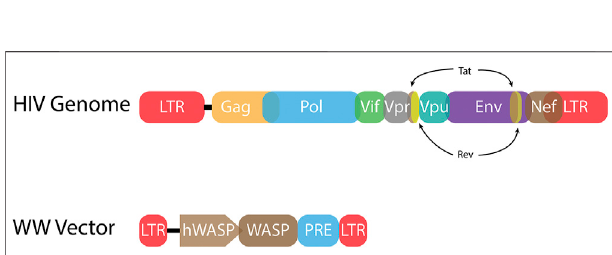
FIGURE 3 | HIV-1 proviral genome and lentiviral vector genome. (Top) The HIV-1 proviral genome (HIV Genome) has long terminal repeats (LTRs) at each end. These non-coding sequences include the terminal sequences that areboundbyintegrase.TheLTRsalsoencodesequencesnecessaryfor viral gene expression including transcription factor binding sites and a TATA box to initiate RNA Pol II transcription. Every retrovirus includes gag, pol , and env genes. These genes encode the structural, enzymatic, and envelope proteins, respectively. HIV-1 also has six accessory genes. Two of these genes, tat and rev , are spliced. (Bottom) A representative lentiviral vector (WW Vector) for treatment of Wiskott-Aldrich syndrome (WAS) encodes the WAS protein ( WASP ) gene driven by the human WASP promoter (hWASP) (Aiuti et al., 2013). The post-transcription regulatory element (PRE) mediates export of unspliced mRNA from the nucleus to the cytoplasm for translation (Zufferey et al., 1999). Much of the LTR sequences have been deleted, including transcription factor binding sites, yielding a self-inactivating (SIN)